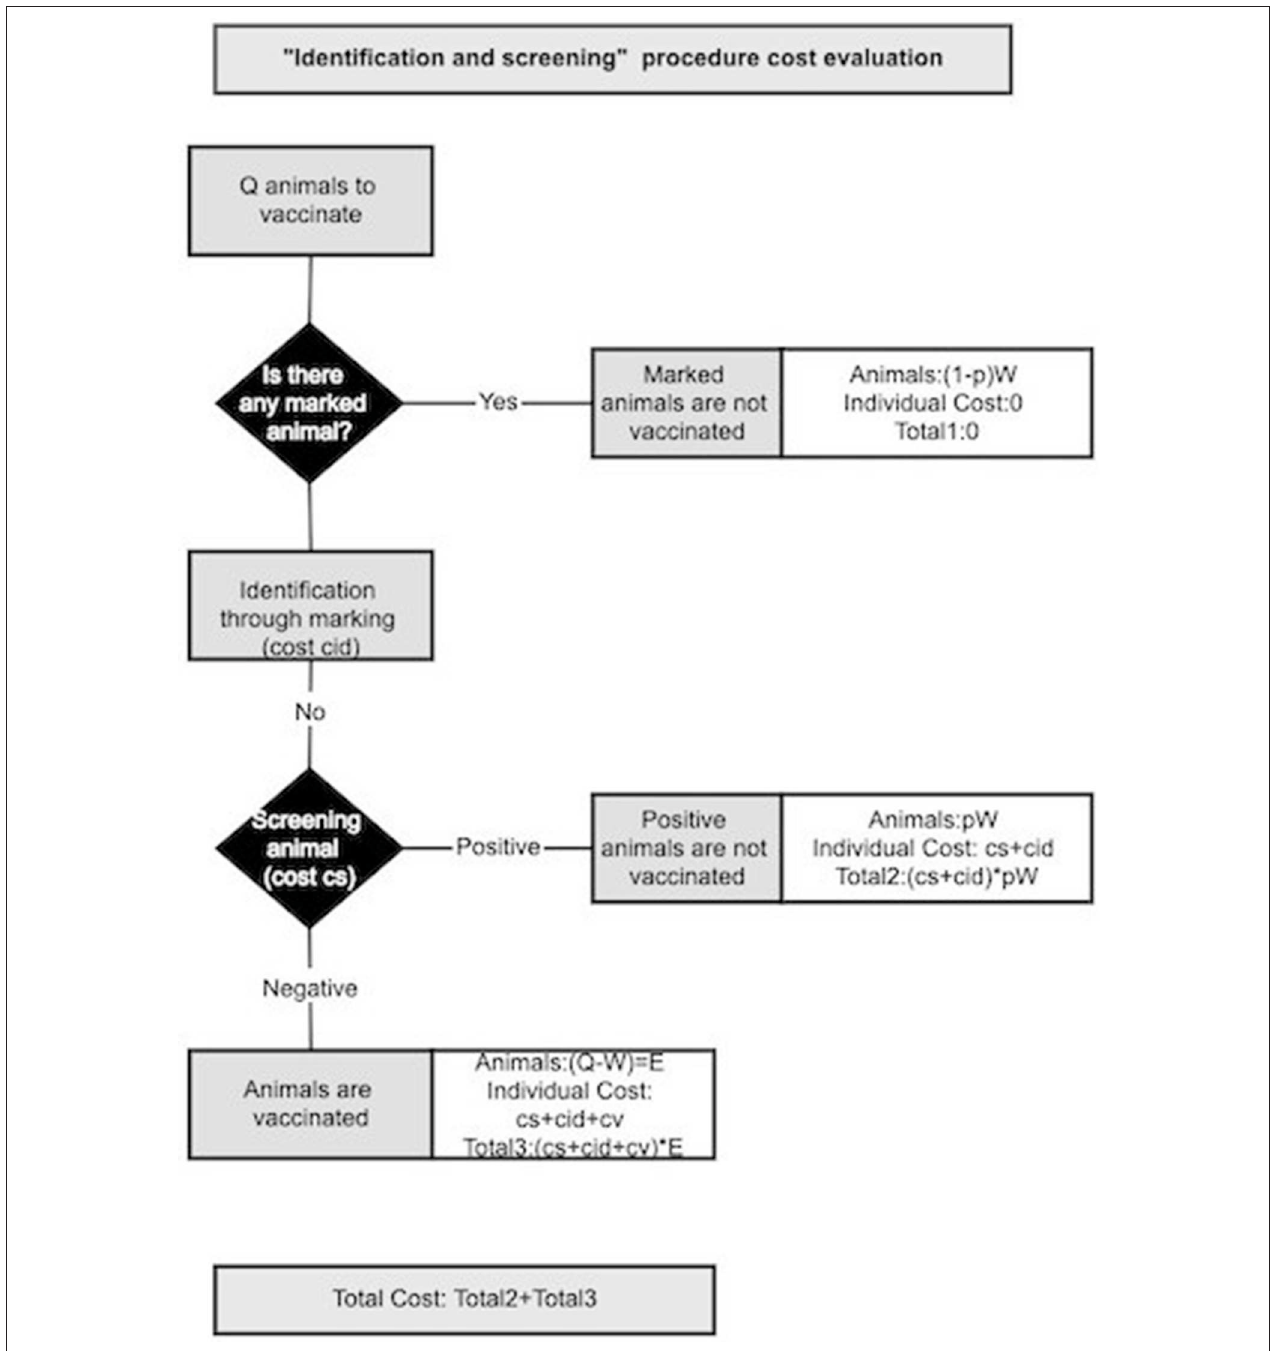
FIGURE 3 | Schematic representation of the cost evaluation for “identification and screening”